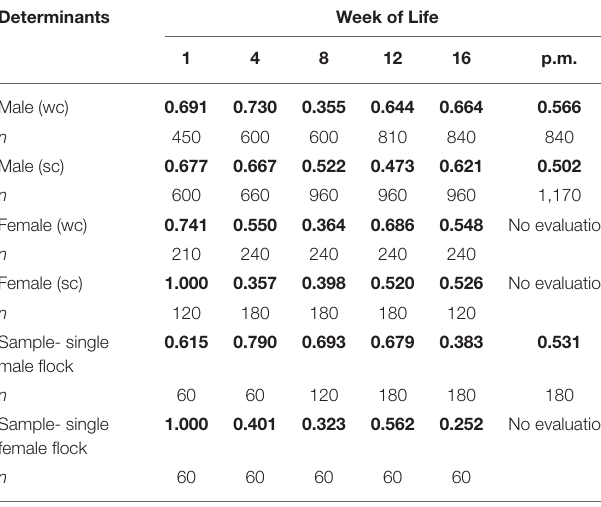
TABLE 1 | Correlation between the right and left foot of an individual bird (r = bold values); flocks divided by sex (summarized sample 11,400 pairs from 13 farms = 37